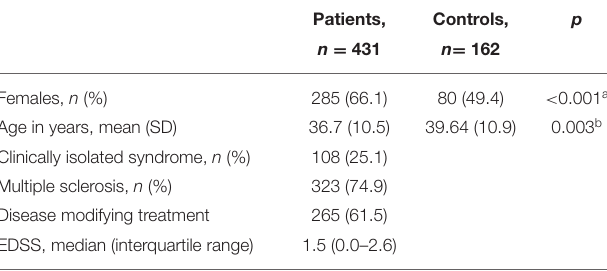
TABLE 2 | Frequency of DVA in patients and controls. Patients with/ Controls